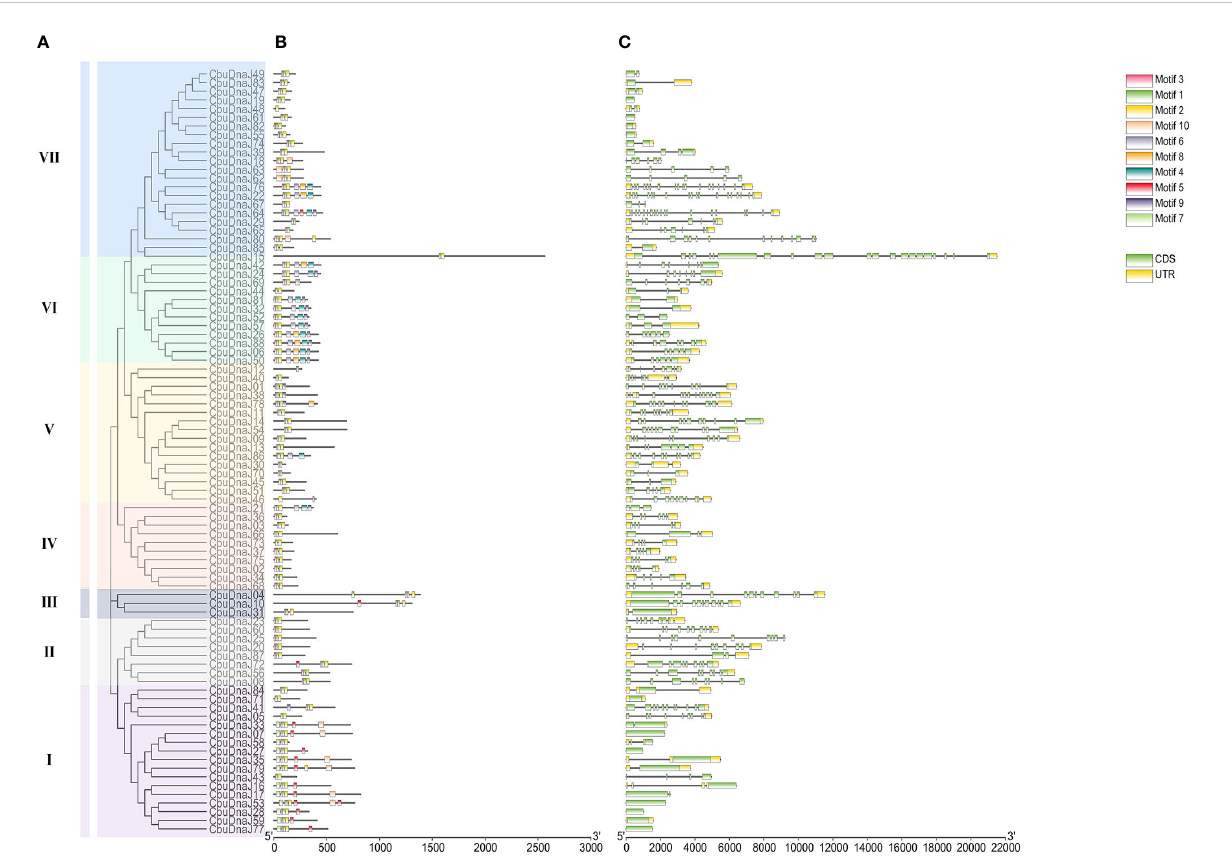
FIGURE 2 Phylogenetic relationships, gene structure and conserved motif analyses of CbuDnaJ s. (A) Phylogenetic tree of CbuDnaJ genes. The CbuDnaJ s can be divided into seven subgroups. (B) Motif distribution patterns. (C) Exon-intron distribution of the CbuDnaJ s. Scale markers represent gene length (bp) and protein sequence length